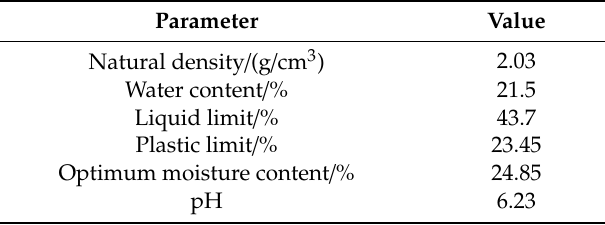
Table 3. Physical properties for studied soil.